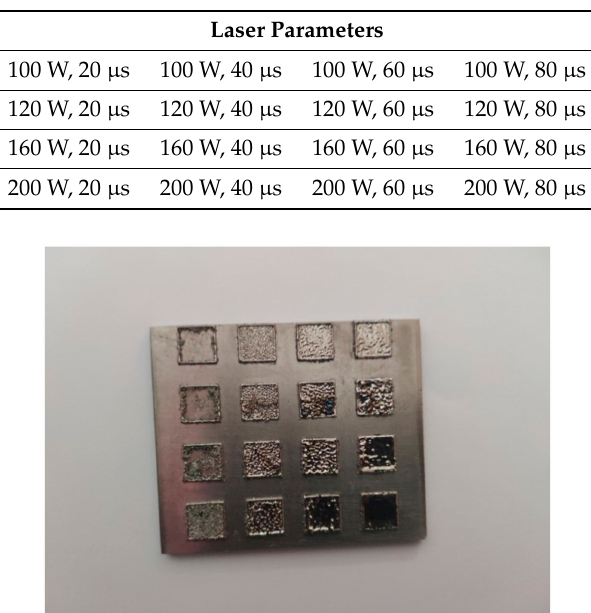
Table 1. Summary of the selective laser melting (SLM) parameters in range study.